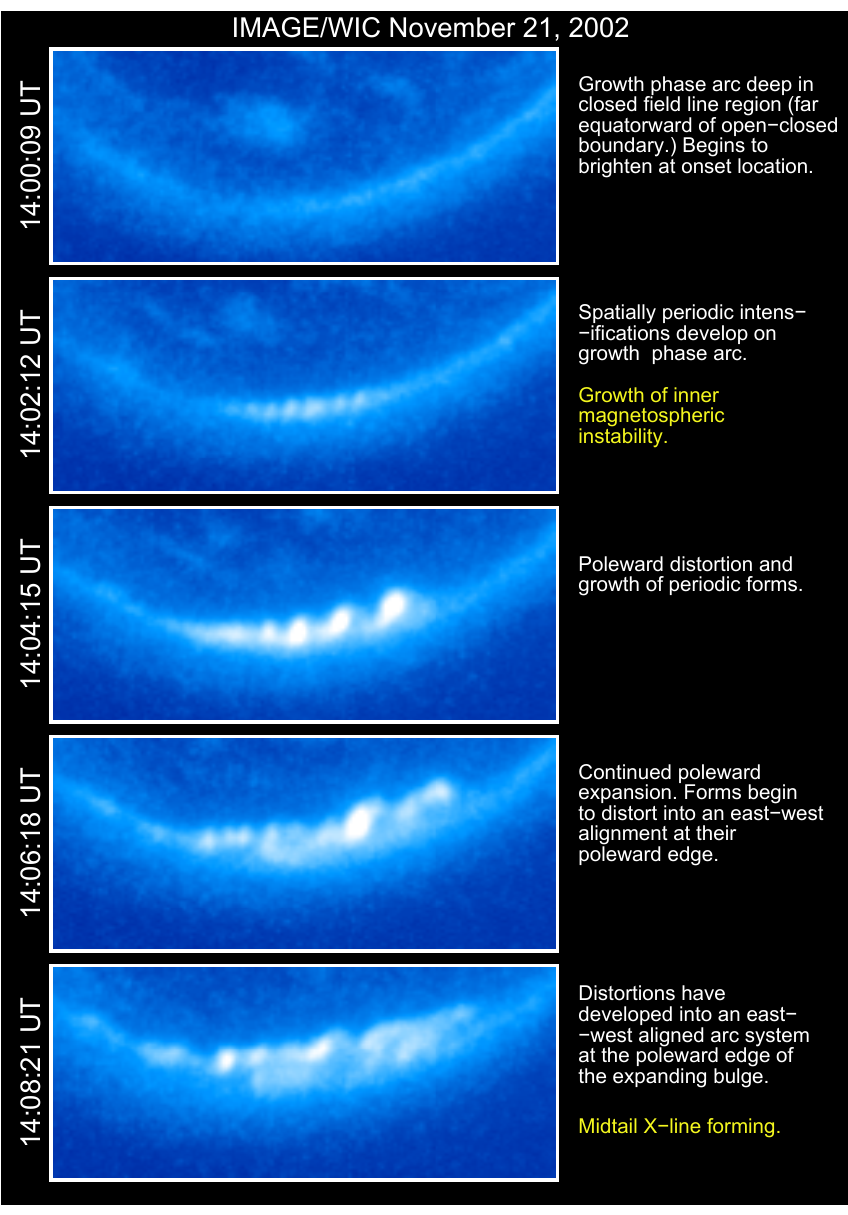
Fig. 2. A close-up view of the onset region. Descriptive comments are given to the right of each image (white text), and an interpretation of the underlying physical cause is given in yellow